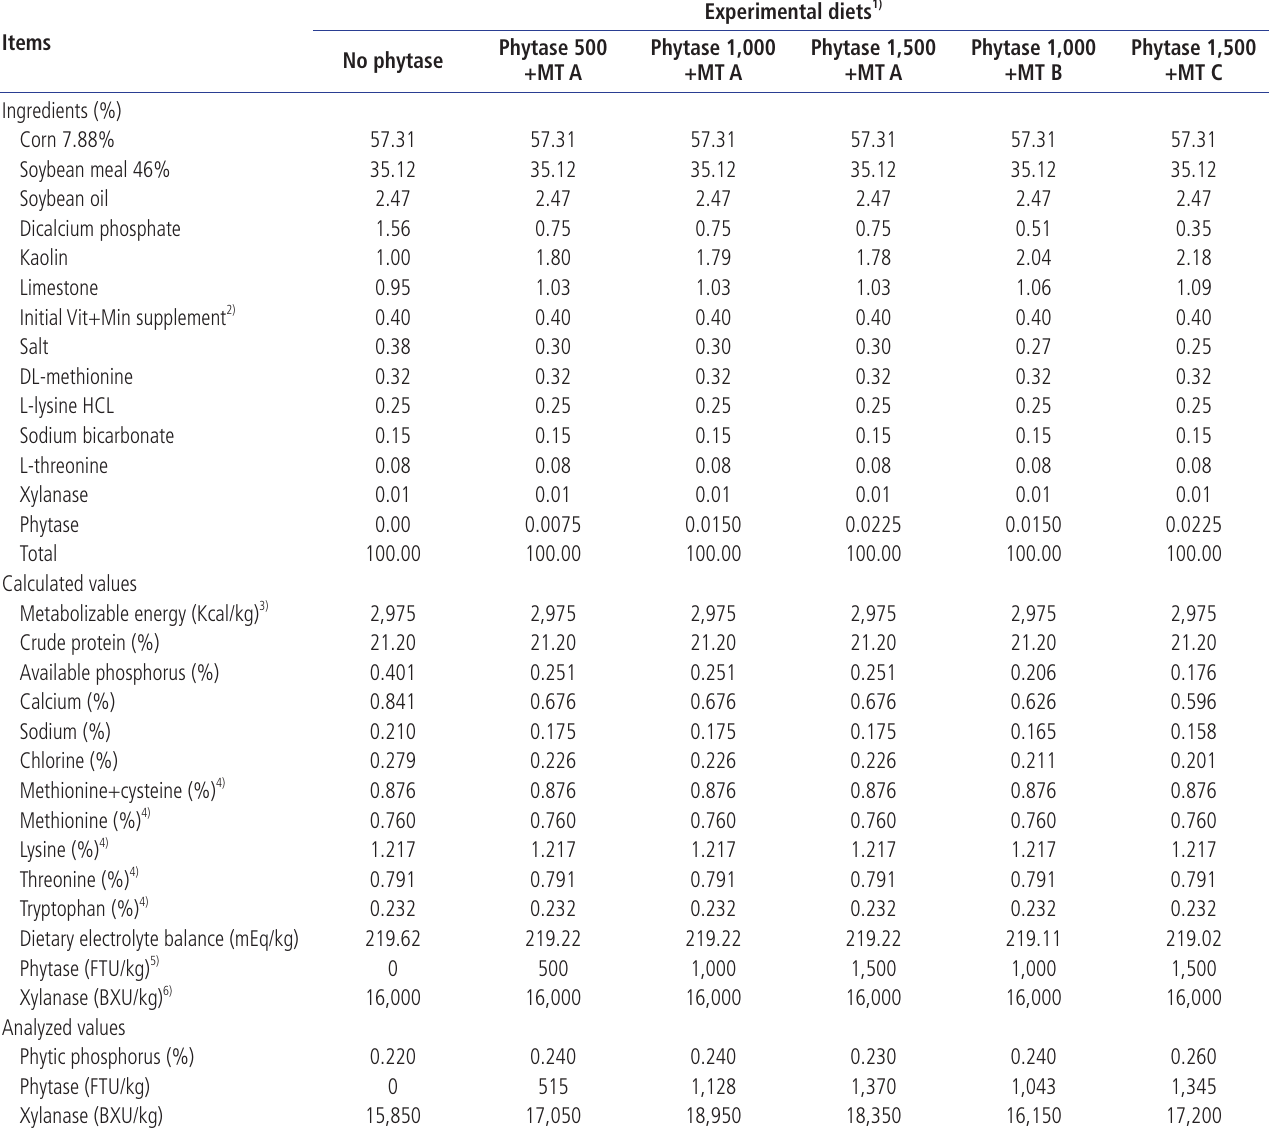
Table 2. Nutritional composition and calculated values of broiler experimental diets (1 to 21